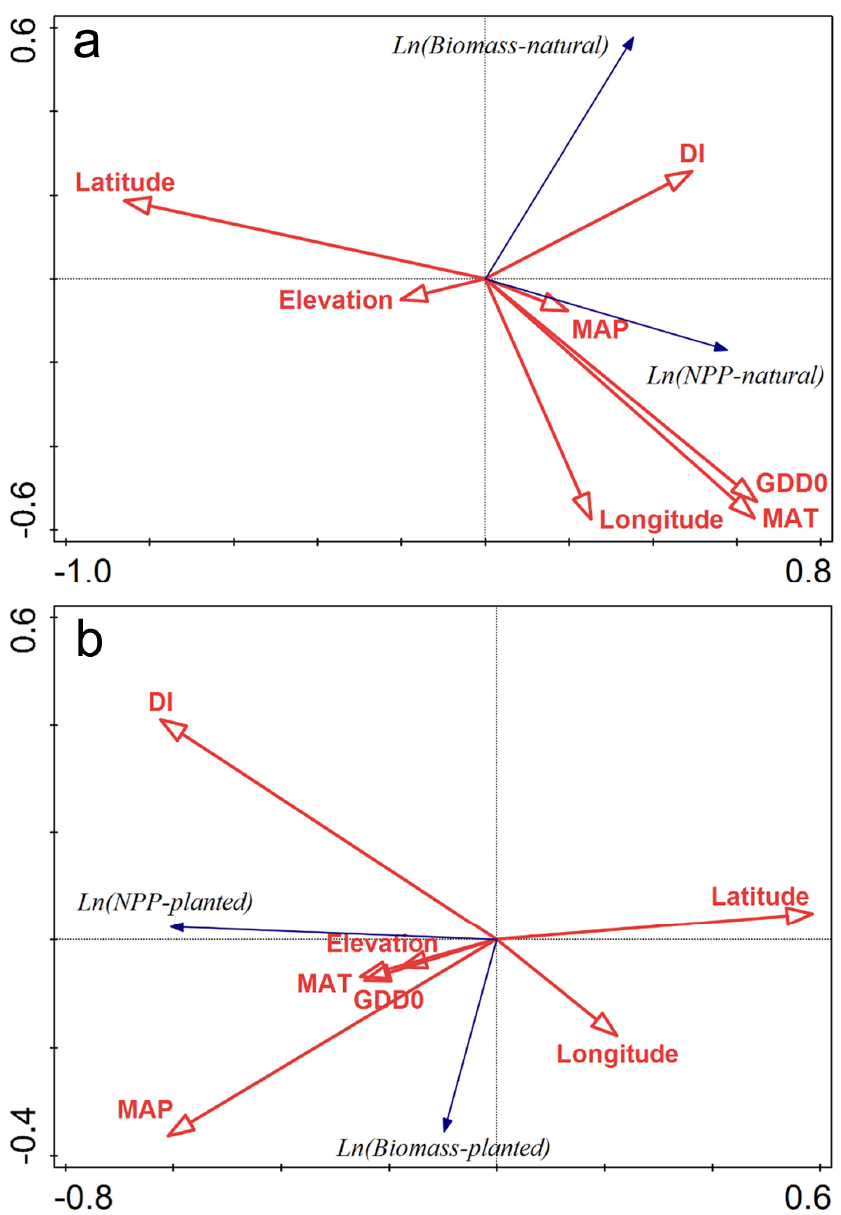
Figure 4. Biplots of biomass/NPP and environmental variables from redundancy analyses. ( a ) Natural forests; and ( b ) planted forests; MAT: mean annual temperature; MAP: mean annual precipitation; GDD 0 : growing degree ‐ days on a 0 °C base; and DI: mean annual drought index.